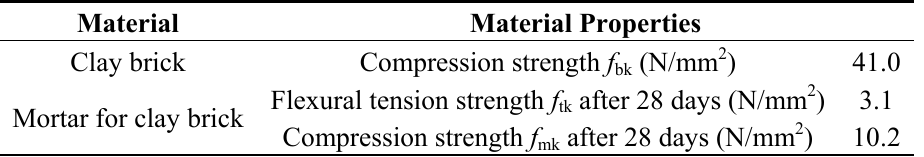
Table 1. Properties for masonry walls.